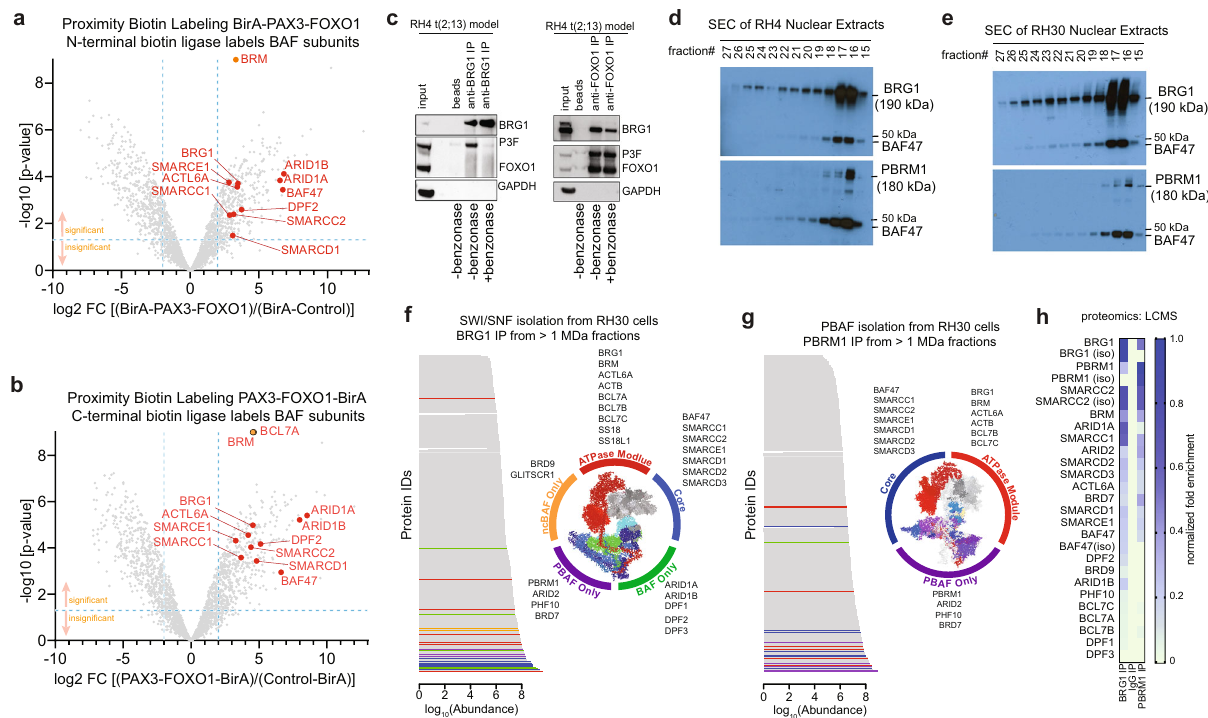
Fig. 2 PAX3-FOXO1 shares spatial proximity with BAF subunits but is not incorporated into stable complexes. a , b Volcano-plots of PAX3-FOXO1 BioID experiments conducted in HEK293T cells. Mass spectrometry was performed on Strep-IP samples after either N- or C-terminal BirA tagged PAX3-FOXO1 and BirA only overexpression. Data points represent comparative protein signal intensities quanti fi ed by MaxQuant software of 4 biological replicates. Signi fi cant enriched proteins ( p < 0.05) with a log2FC > 2.5 in PAX3-FOXO1/BirA compared to BirA only Strep-IP samples are found in the upper right quadrants. mSWI/SNF complex members within this section are labeled. MaxQuant analysis results applying moderated t -test (for detailed information refer to methods section). ( c ) Western blot detection of indicated endogenous proteins in anti-BRG1 or anti-FOXO1 immunoprecipitates from RH4 cells. Beads served as negative control. Lysates were digested or not with 250 U/ml Benzonase. d , e Size-exclusion chromatography (SEC) performed on RH4 and RH30 FP-RMS cell lines, followed by western blotting the fractions for BRG1, BAF47, or PBRM1. Internal standards indicate fractions 15/16 are